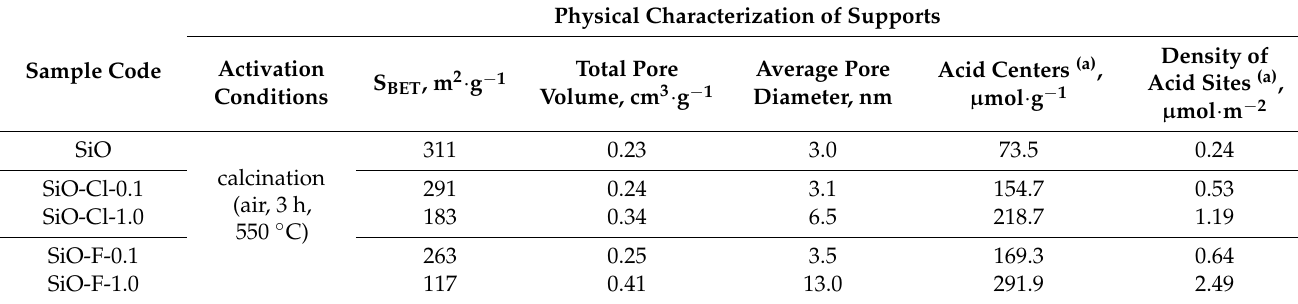
Table 1. Physicochemical properties of the unmodified and modified silicas.